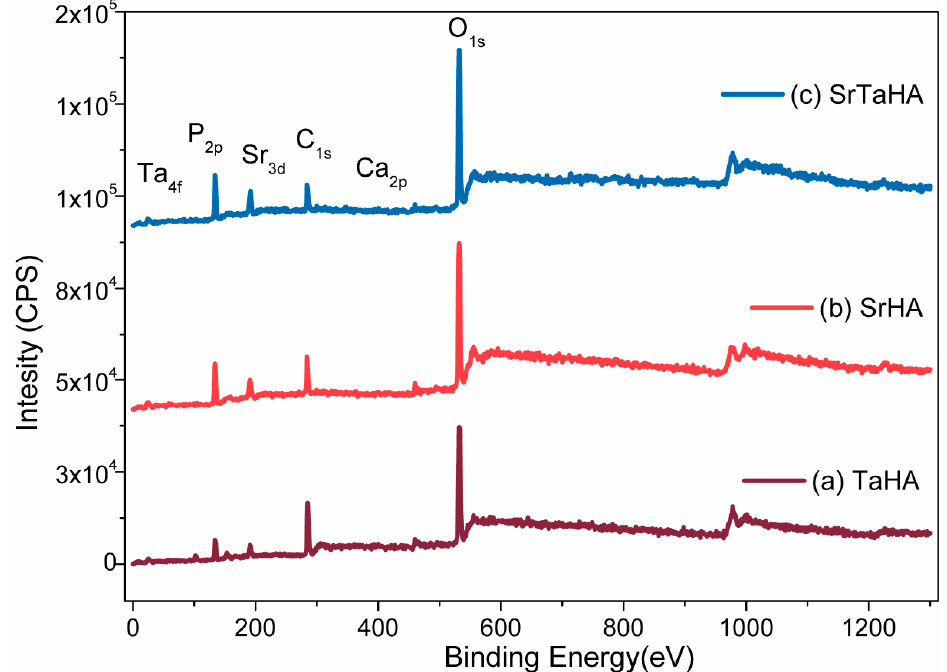
Figure 10. XPS spectra with all elements of ( a ) TaHA ( b ) SrHA and ( c ) SrTaHA coatings.